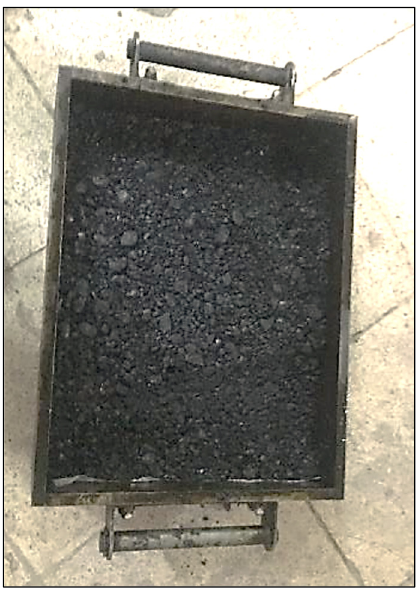
Figure 14. Samples rectangular metal mold.